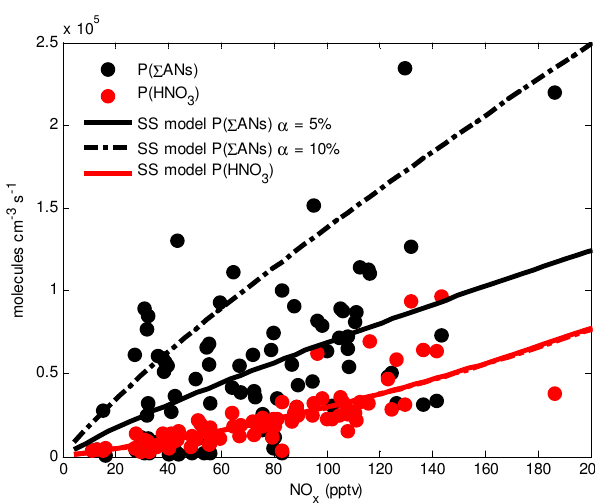
Fig. 3. Calculated instantaneous production rates of HNO 3 (red) and 6 ANs (black) as a function of NO x . The points are calculated using in situ observations as described in Appendix A. The lines are calculations from the steady-state model described in Browne and Cohen (2012). The two black lines shown assume branching ratios of 5% (solid black line) and 10% (dashed black line) for 6 ANs production from the reaction of RO 2 with NO. These two branch- ing ratios are assumed to bracket the values expected in forested